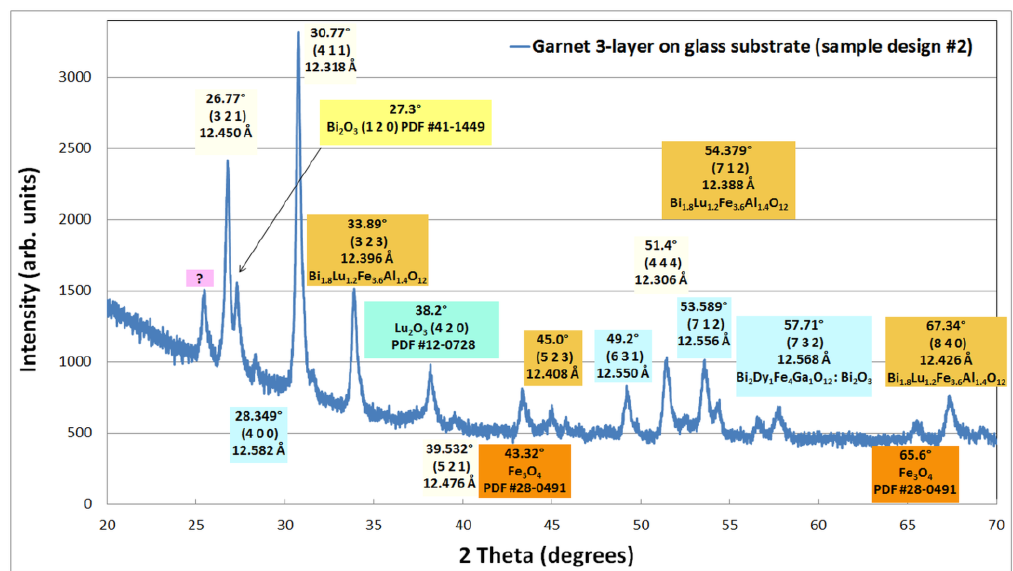
Figure 4. X-ray diffraction data set obtained from an annealed all-garnet multilayer sample of type SD2 (with individual layers of 500 nm thickness, deposited onto a glass substrate), which has demonstrated an unconventional magnetic hysteresis loop